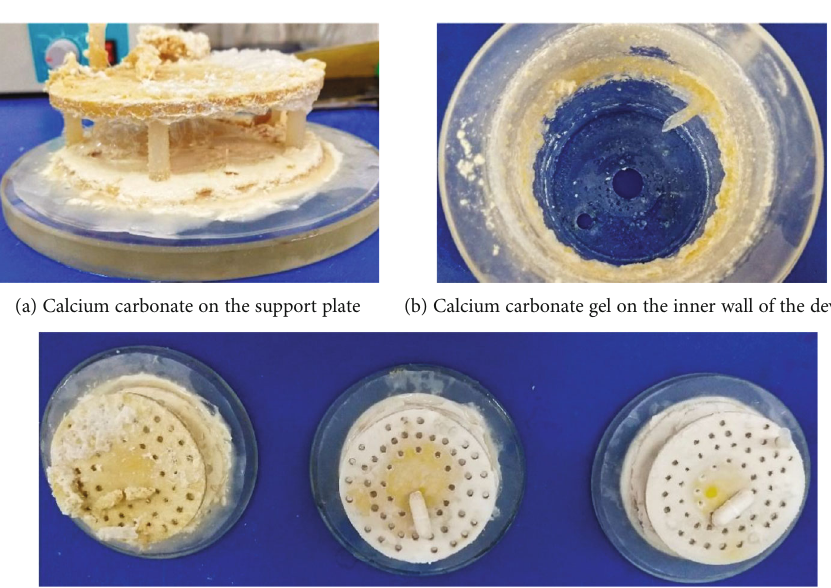
Figure 3: Calcium carbonate sample after device removal.